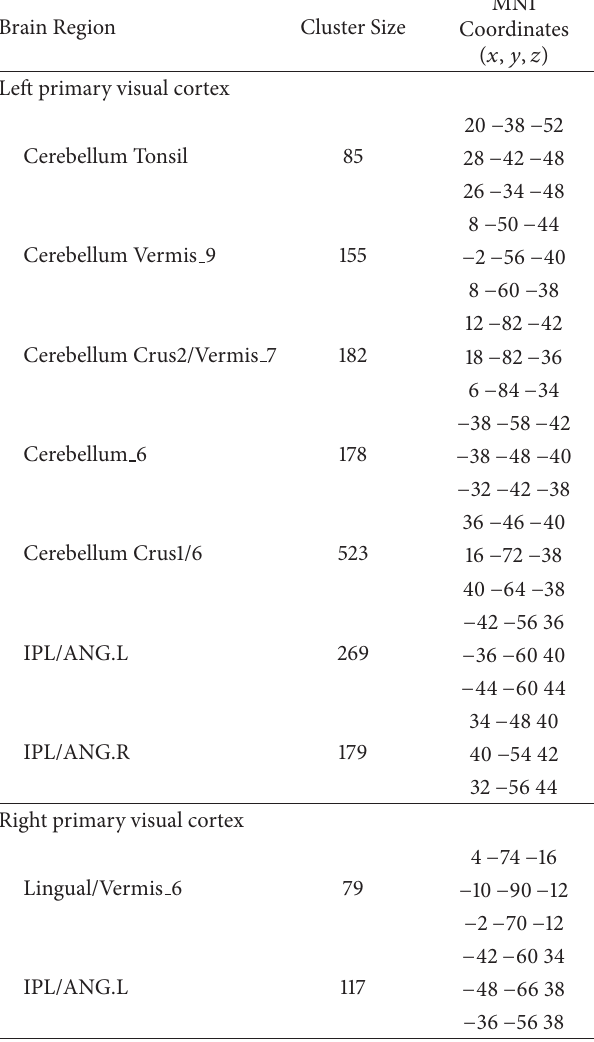
Table 2: Overlapping brain areas with altered functional connec- tivity with the primary visual area in amblyopia individuals (cluster size >